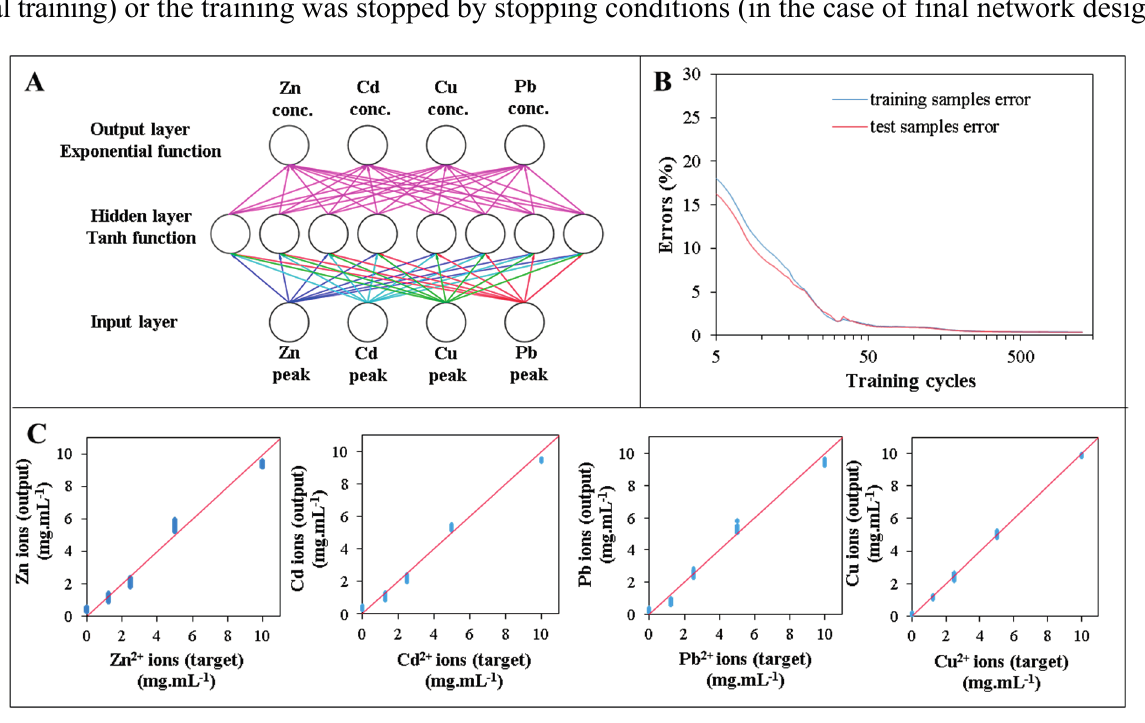
Figure 4. ( A ) Design of the final custom neuronal network model with four input,